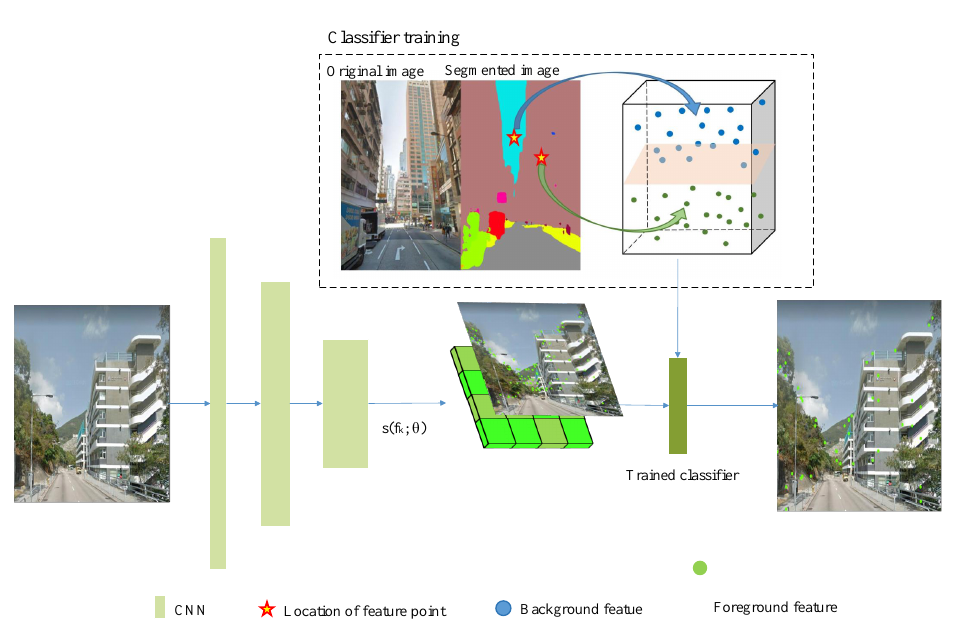
Figure 5. Extraction architecture of BAF: green bright spots is feature descriptors. After classification of building-aware classifier, number of descriptors falling on sky, woodland, etc., decreased significantly. The output f s ∈ R k , n = 1, . . . , M is the feature vector with attention score. M is the top M features ranked according to the attention scores. θ denotes parameters of